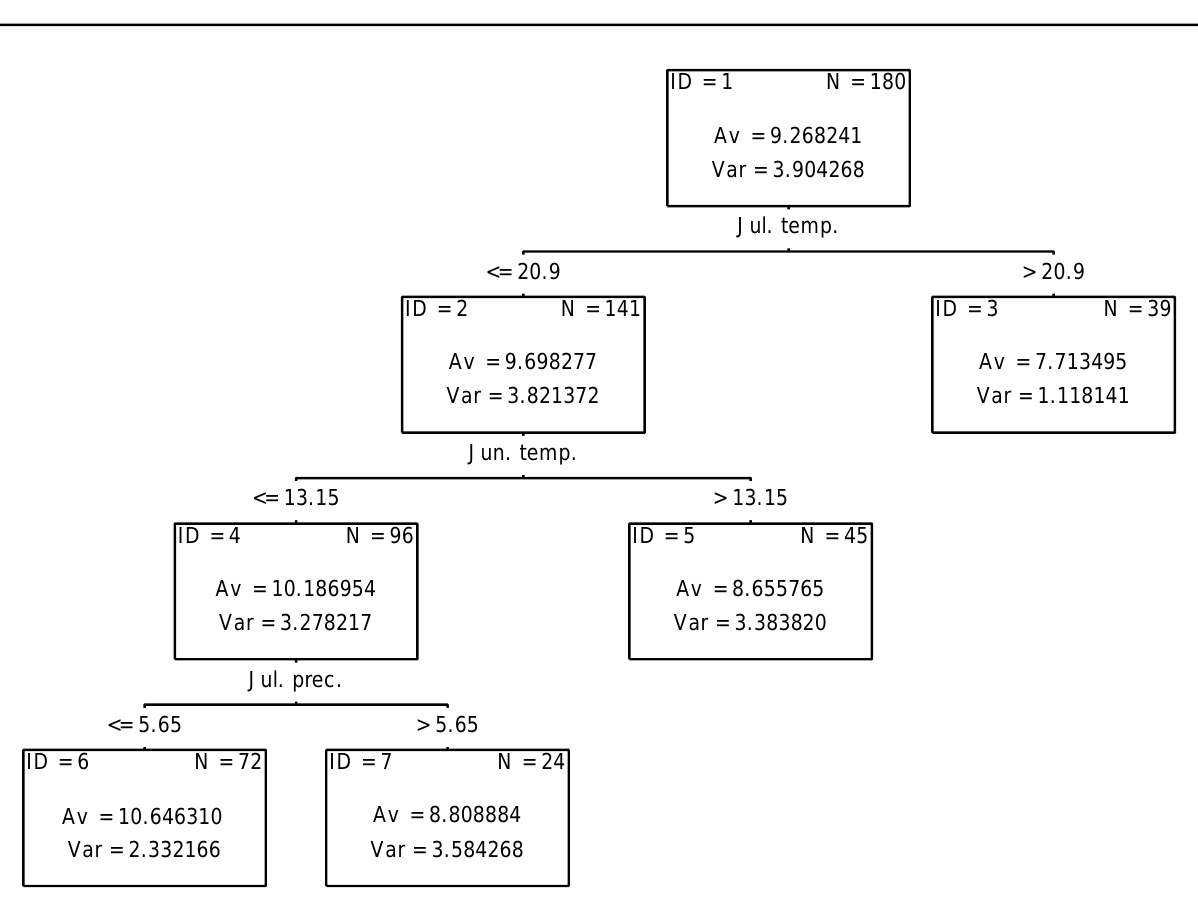
Figure 7. Diagram of regression tree reflecting nitrogen acquisition from fertiliser by control soybean plants.